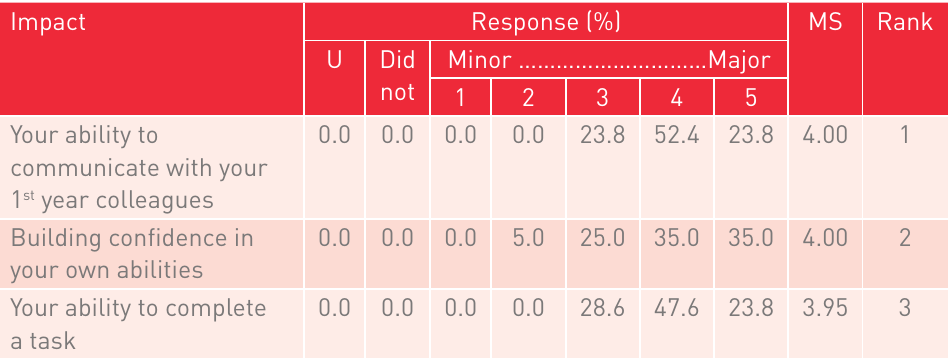
Extent to which the team building activities impacted on